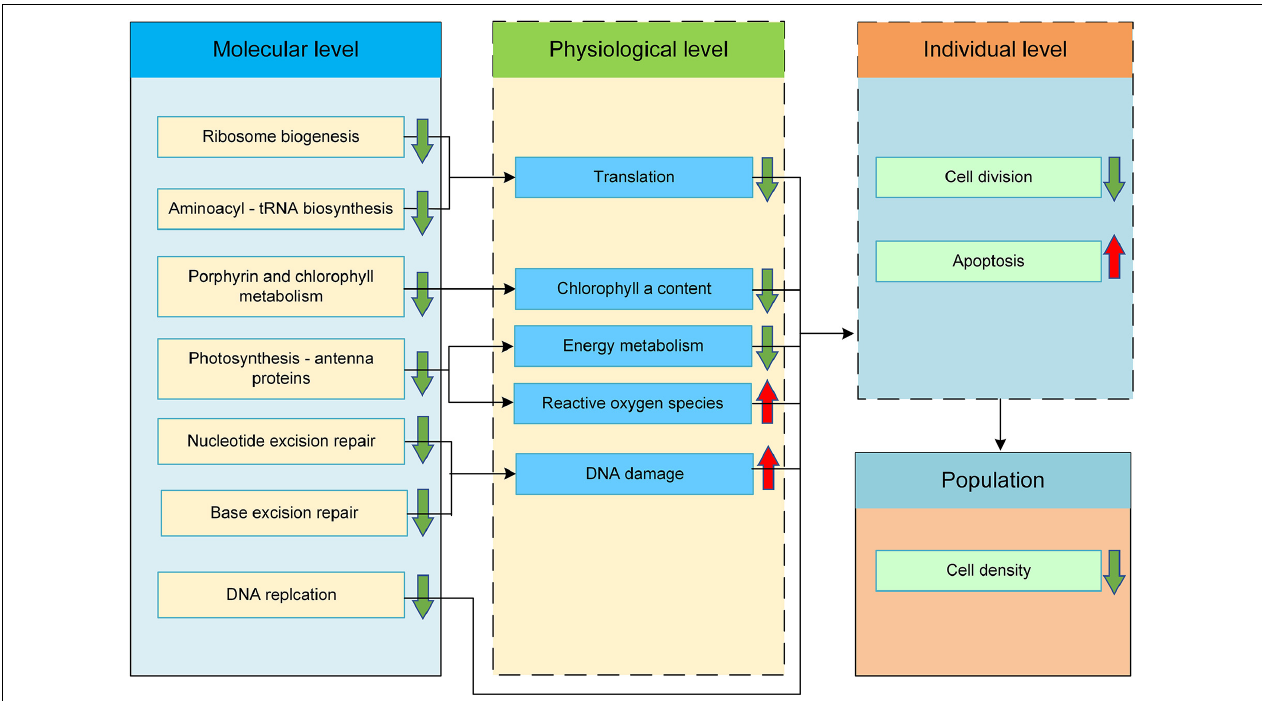
FIGURE 4 | Proposed molecular mechanism of action of SMX in green alga R. subcapitata . Changes in the physiological and individual levels were predicted based on the enriched